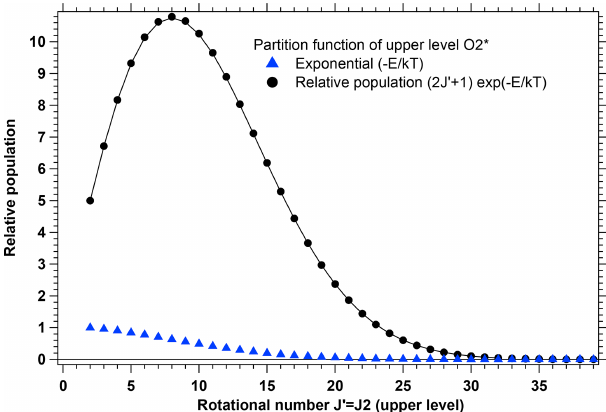
Figure A2. Partition function of the O 2 ∗ molecule as a function of rotation state J (cid:48) for T = 296K. Blue triangles indicate exponential terms for population, with 1 being the lowest. Black circles indicate the relative population computed from information contained in the HITRAN database of transitions. It allows to retrieve the allowed values of J (cid:48) . The first point is for J (cid:48) = 2 with a value of 5 = 2 J (cid:48) + 1, and exp ( 0 ) = 1. The sum of all relative populations is Q (cid:48) up tot by definition.